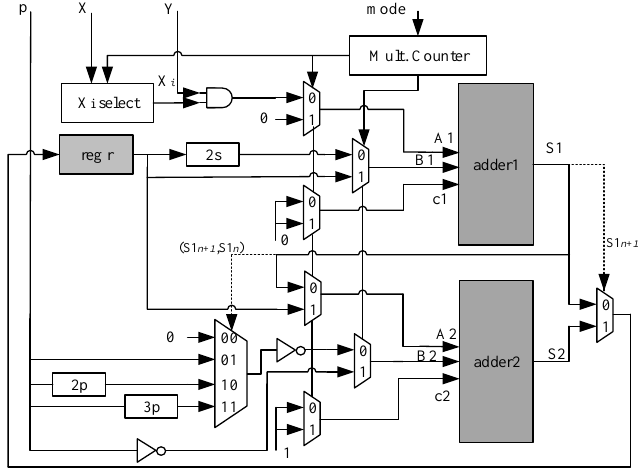
Figure 2. Multiplication diagram.